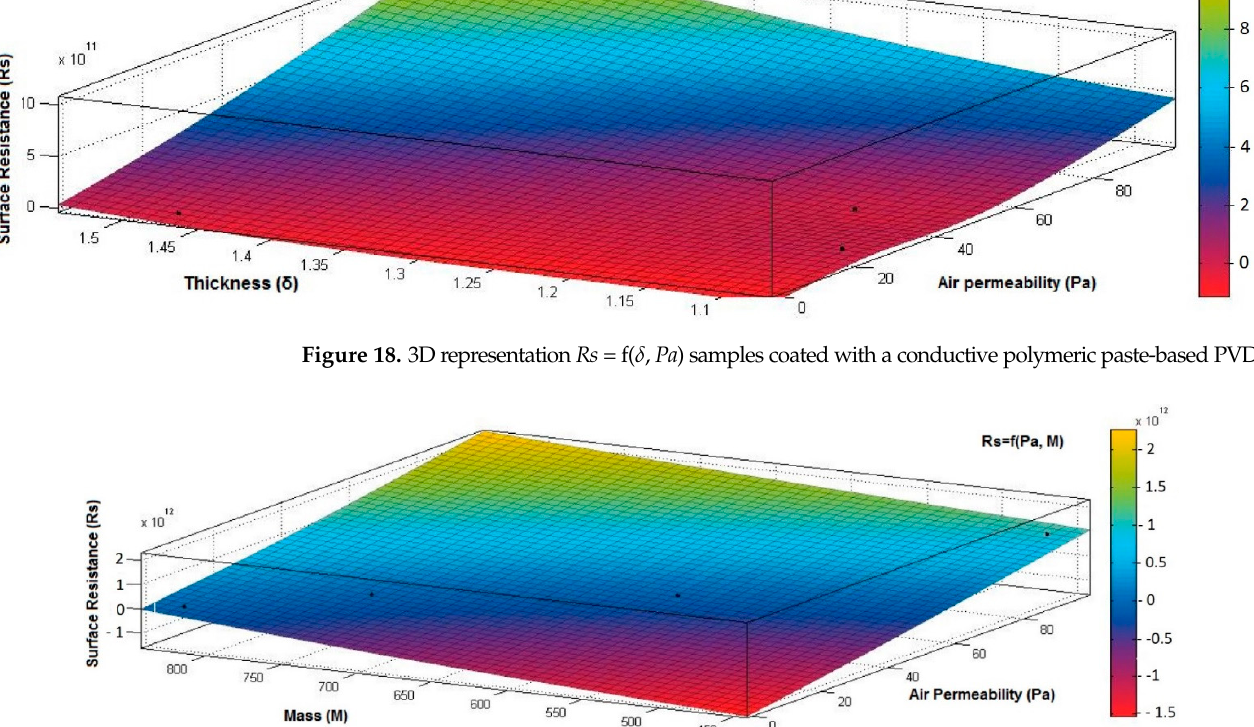
Figure 19. 3D representation Rs = f (M , Pa) samples coated with a conductive polymeric paste-based PVDF.